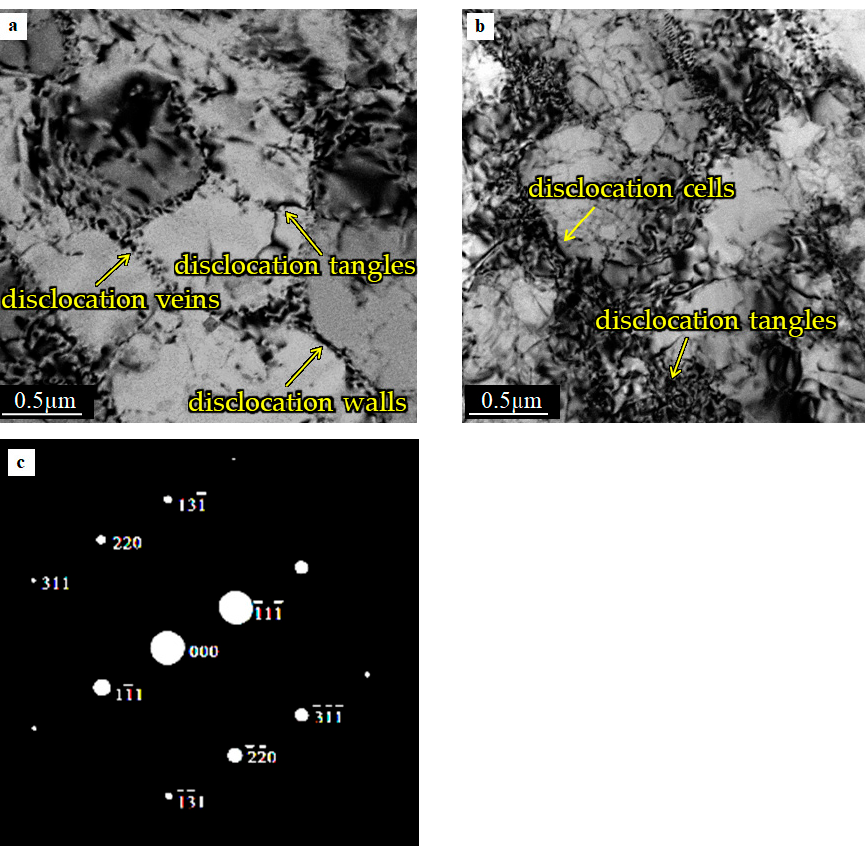
Figure 13. The microstructure in the aluminum part of the weld at the distance of 20 mm from the interface ( a , b ), SAD from the sub-grains arranged in the central part of Figure 13b ( c ). In two-electron micrographs (Figure 13a,b), typical dislocation cell microstructures